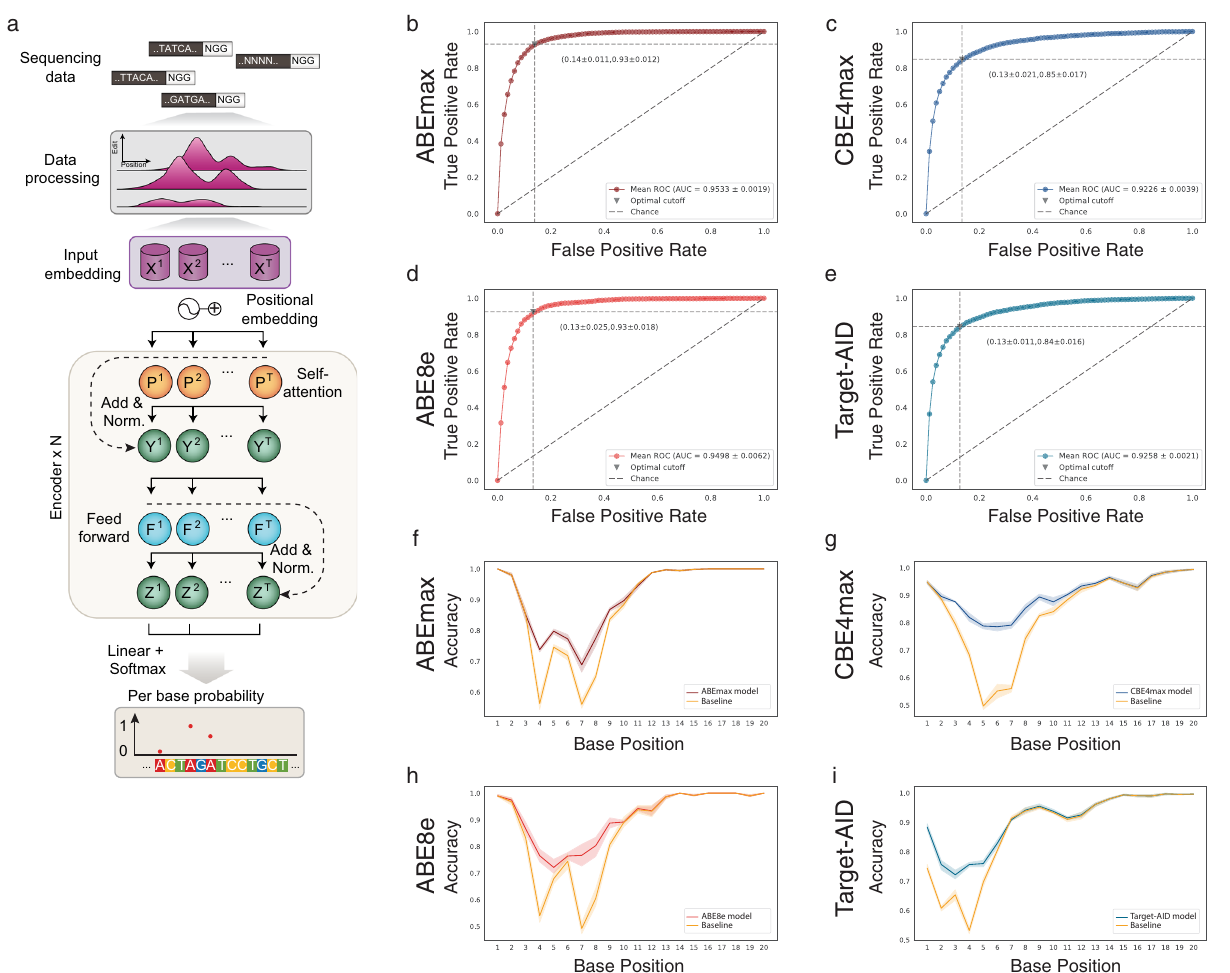
Fig. 2 BE-DICT: A machine learning model for predicting base editing outcomes. a Design of an attention-based deep learning algorithm to predict base editing probabilities. Given a target sequence, the model returns a con fi dence score to predict the chance of target base conversions. The model has three main blocks: (1) An embedding block that embeds both the nucleotide and its corresponding position from one-hot encoded representation to a dense fi xed-length vector representation. (2) An encoder block that contains a self-attention layer (with multi-head support), layer normalization 31 and residual connections, and a feed-forward network. (3) An output block that contains a position attention layer, and a classi fi er layer. b – e The average AUC achieved across fi ve runs (interpolated) for models trained on data from high-throughput base editing experiments. f – i Line plot of per-position accuracy of the trained models across fi ve individual runs for base editors in comparison to the accuracy of majority class baseline predictor. Standard deviation is depicted as a band along with the line